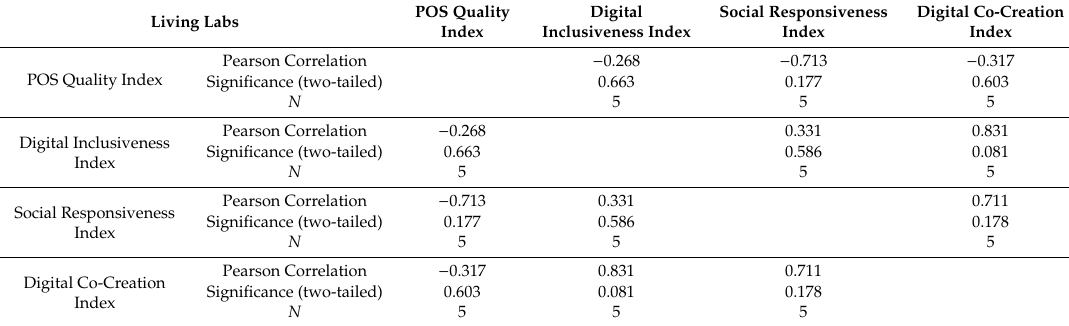
Table 2. Correlation analysis of POS Quality Index, Digital Inclusiveness Index, Social Responsiveness Index and Digital Co-Creation Index of 4 Living